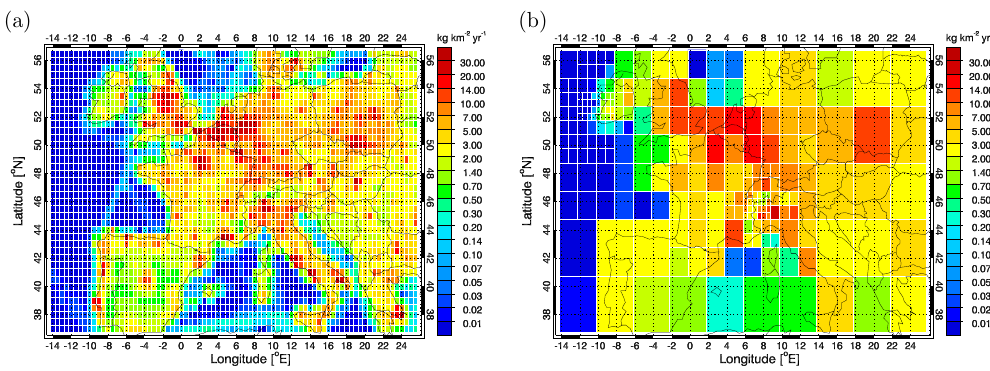
Fig. 3. CO emissions in 2005 according to EMEP/CEIP (http://www.ceip.at/) inventory and reduced by a factor 1000 to match the range of halocarbon emissions. (a) Emissions on regular 0 . 5 ◦ × 0 . 5 ◦ grid. (b) Emissions on reduced grid with 224 cells used for the inversion.